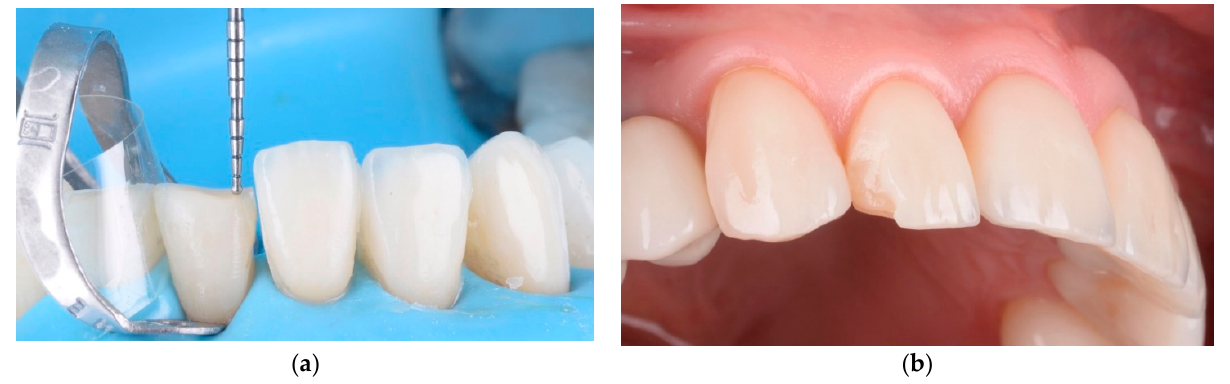
Figure 11. ( a ) When the thickness of the veneers exceeded 2 mm, future fractures could result because of unsustained ceramic; ( b ) chipping of the feldspathic ceramic veneers was observed.